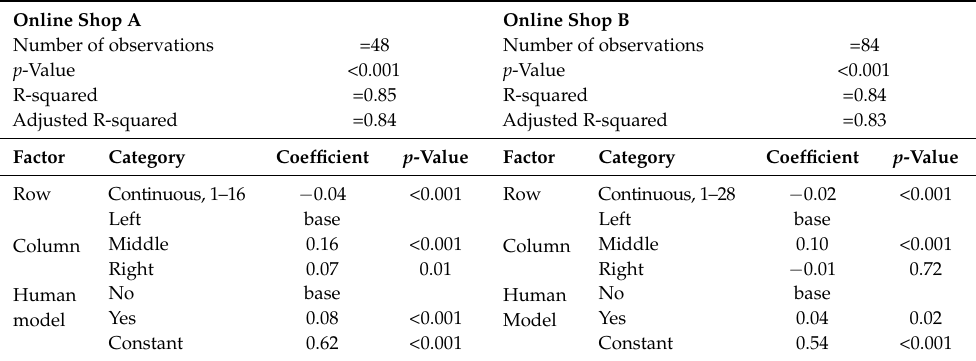
Table 1. Results of the linear regression analyses estimating the influence of the independent variables (factors) on the percentage of participants visiting an AOI (product depiction).